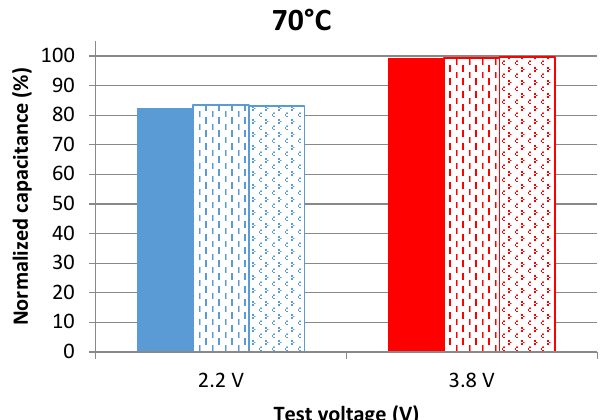
Figure 4. Capacitance evolution of cells aging at 2.2 V and 3.8 V at 70 °C after 109 days of calendar aging. The results are found from measurements in the time domain at 25 °C.